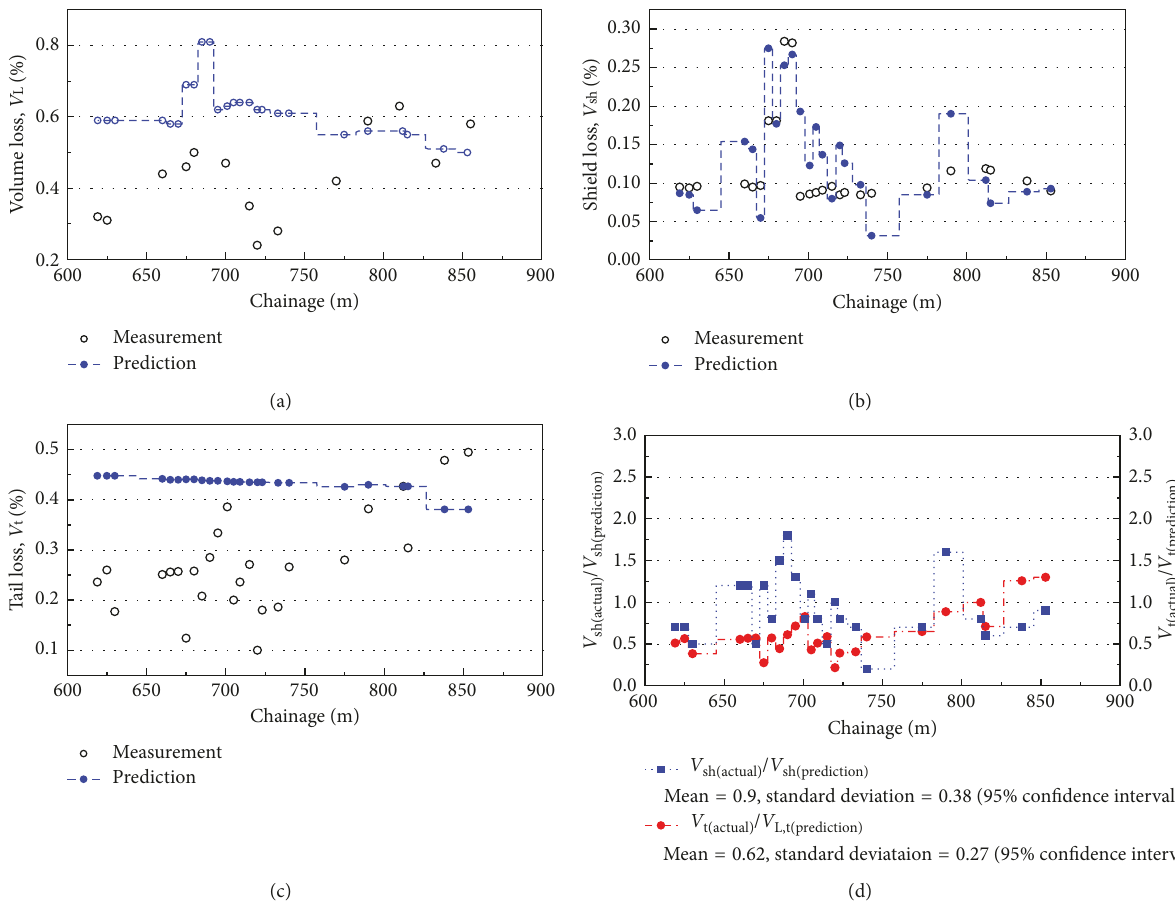
Figure 8: Comparison of volume loss between measurement and predictions for down-track tunnel: (a) total volume loss, (b) shield loss, (c) tail loss, and (d) relative magnitude of observed/predicted volume